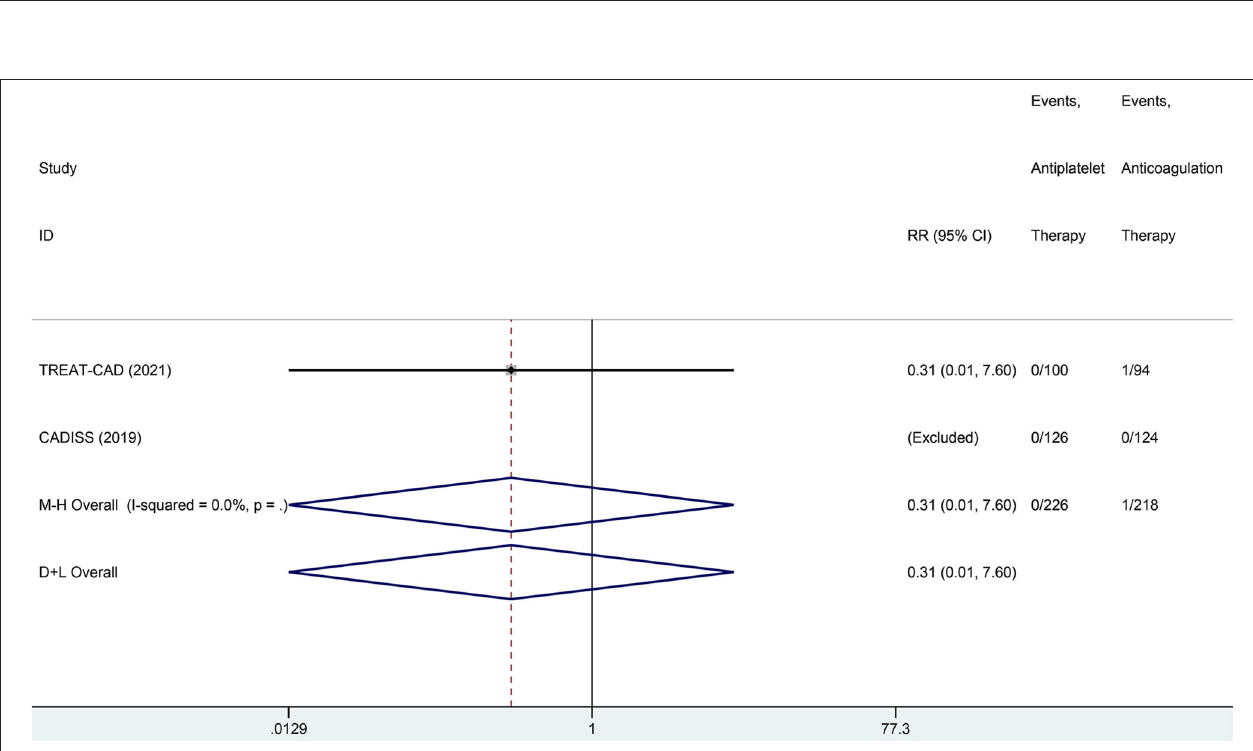
Frontiers in Neurology |